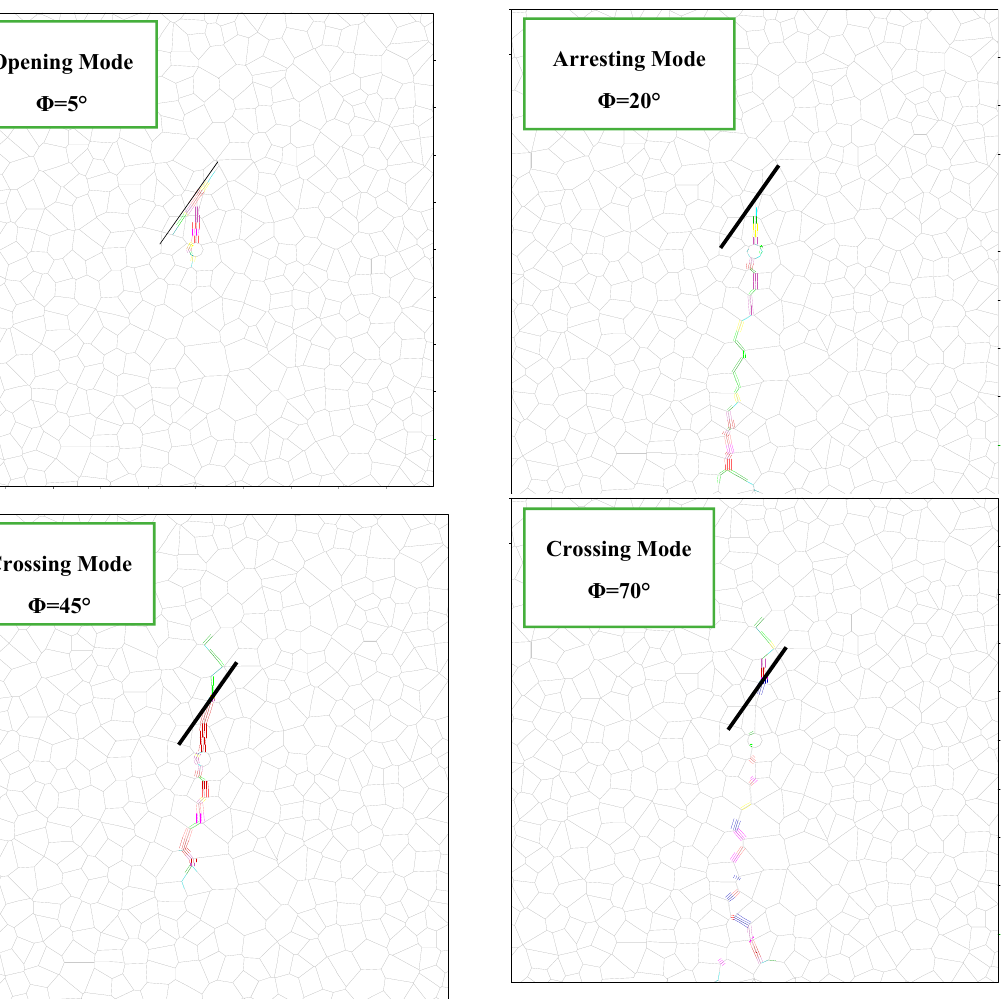
Figure 9. E ff ect of friction angle on the HF propagation (approach angle of 33 ◦ and ∆ σ of 10 MPa). Figure 9. Effect of friction angle on the HF propagation (approach angle of 33 degrees and Δσ of 10 230 Changing mode was not observed with increase in C values of NF in numerical